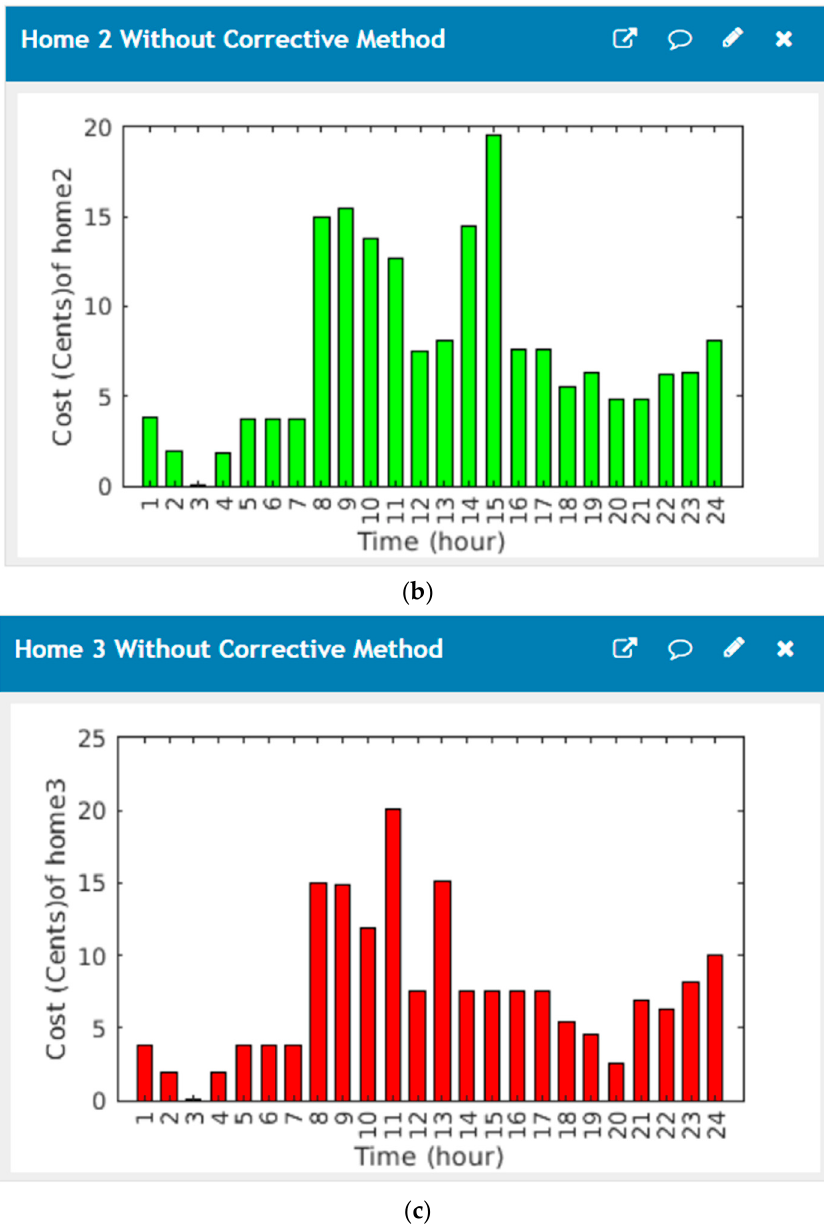
Figure 9. Cost GUI of the suggested home structure without corrective method: ( a ) cost profiles of the first house; ( b ) cost profiles of the second house; ( c ) cost profiles of the third house.